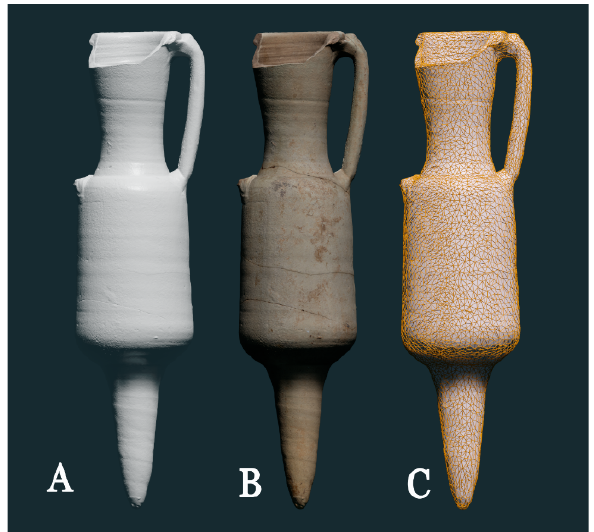
Figure 2. Different representations of a digitized Roman amphora with photogrammetry. A. High-resolution mesh; B. Low-poly mesh with high-resolution textures; C. Low-poly